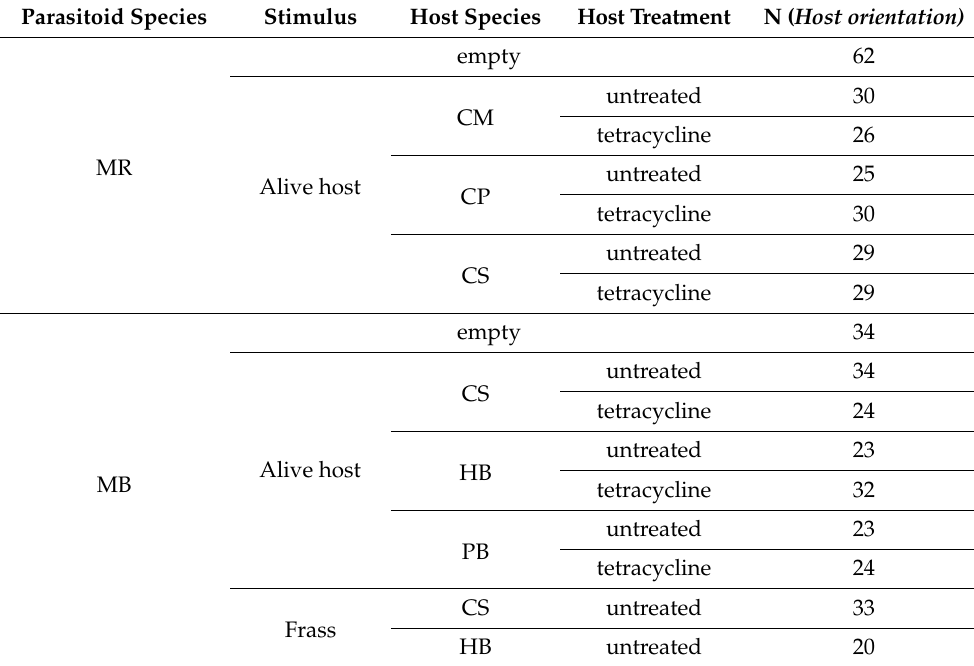
Table 1. Summary of the treatments for testing host orientation in Mallophora ruficauda and M. bigoti . MR: M. ruficauda ; MB: M. bigoti ; CS: Cyclocephala signaticollis ; CM: C. modesta ; CP; C. putrida ; HB: Heterogeniates bonariensis ; PB: Plectris bonariensis